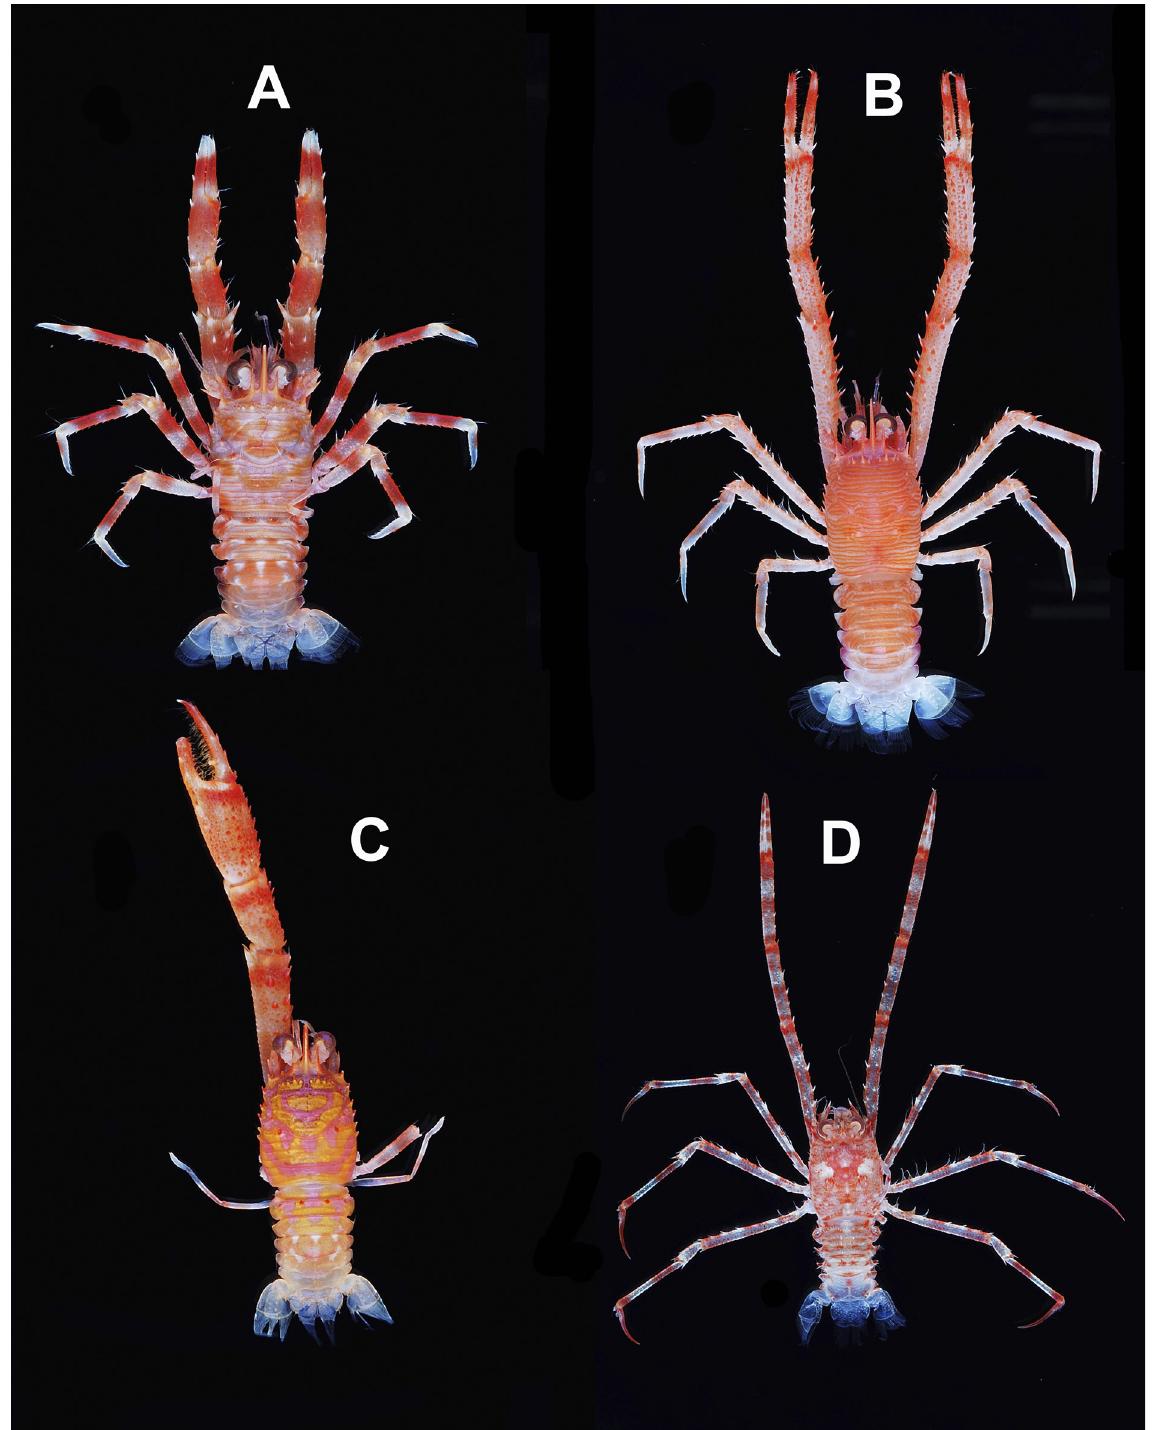
Fig. 13. Dorsal view. Colours in life. A . Munida nesiotes Macpherson, 1999, ov. ♀, 8.5 mm, Mozambique, MAINBAZA, Stn CP3143. B . Munida shaula Macpherson & de Saint Laurent, 2002, ov. ♀, 12.4 mm, Mozambique, MAINBAZA, Stn CC3151. C . Munida tetracantha sp. nov., paratype, ♂, 7.4 mm, Mozambique, MAINBAZA, Stn CP3131. D . Paramunida marionis Cabezas et al. , 2011, ♀, 6.0 mm, Mozambique, MAINBAZA, Stn